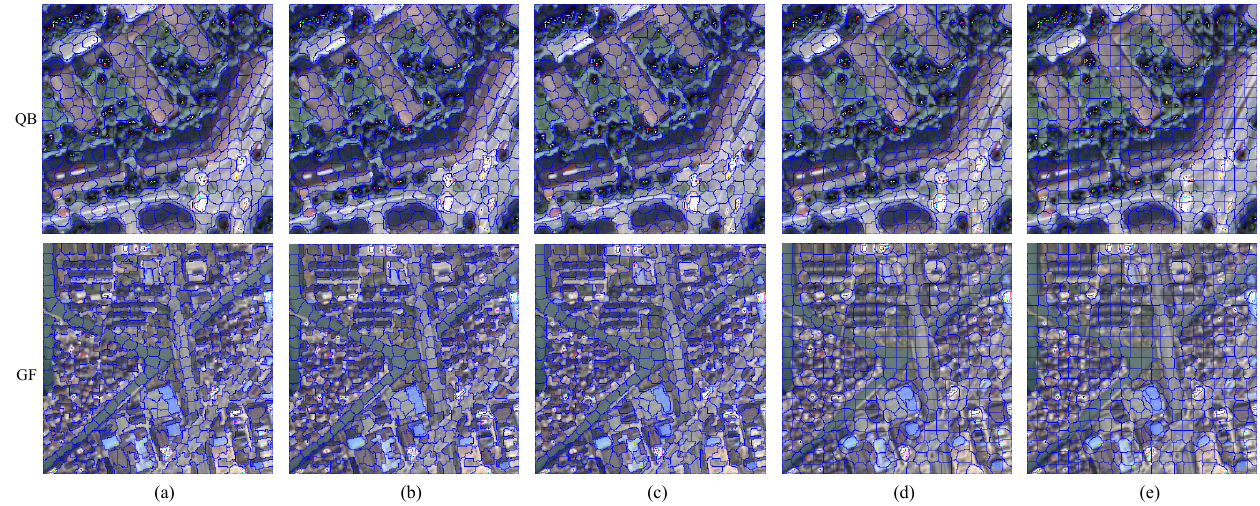
Figure 6. Superpixel-segmentation results on partial GF and QB by different segmentation parameters, where the tightness parameters of ( a – e ) are 1, 15, 30, 45, and 60, respectively.